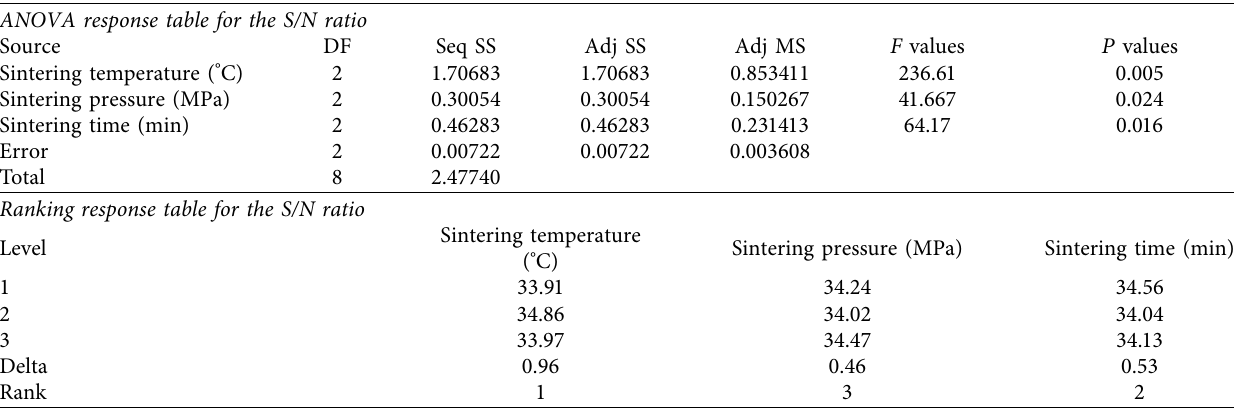
Table 4: ANOVA analysis for the S/N ratio of microhardness. ANOVA response table for the S/N